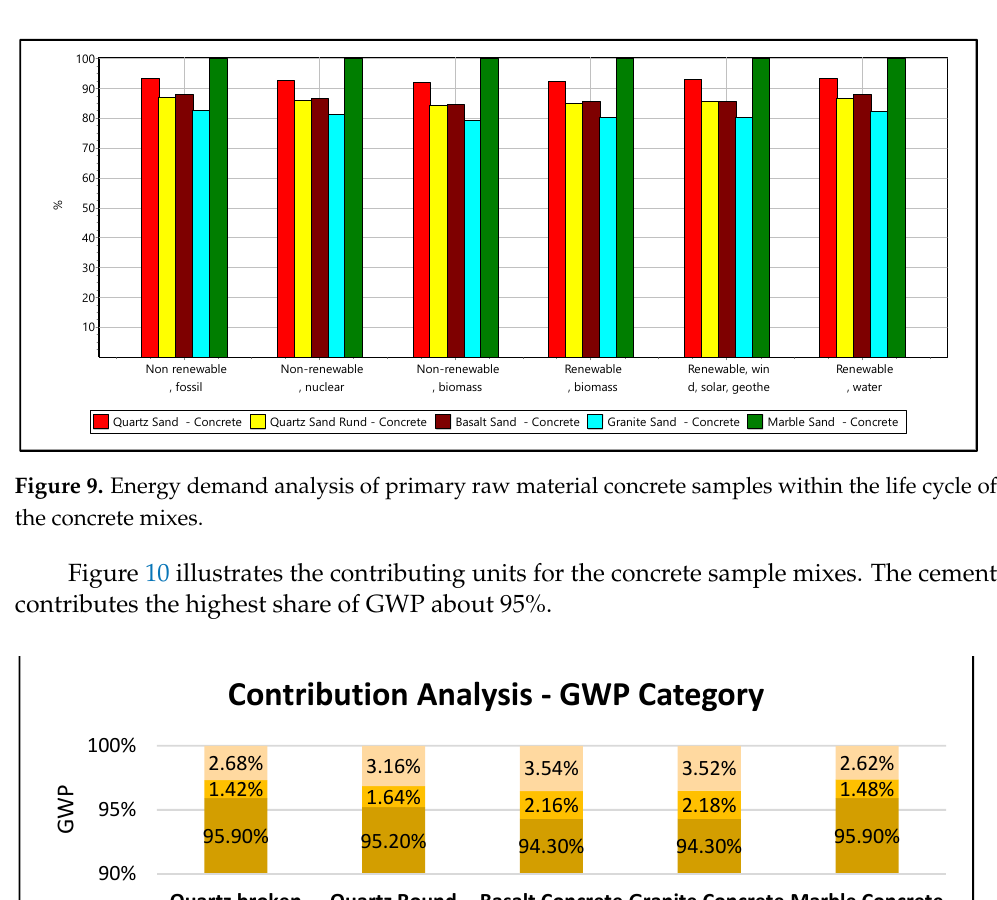
13 of 20 Figure 8. LCA comparison of primary raw material concrete samples across different impact cate- gories. Among the different aggregate usage in the concrete, the granite-based concrete has the least impact with 346 kg CO 2 eq per m 3 of concrete. The granite-based concrete has a 20% lower GWP impact than marble based concrete. The basalt concrete and crushed rounded quartz concrete has a 15% lower GWP impact than marble concrete. The cement contributes the highest share of GWP about 95%. The remaining contribution arises from aggregate about 1.4–2.18% and transportation processes contributing 2.68%–3.54%. The variation in the GWP contribution from aggregates was directly related to their mass pre- sent within the concrete mixes. Among the aggregates, the marble concrete utilizing lime- stone-based unit process shoed higher mineral resource scarcity. This could be based on the characterization values associated with limestone and the absence of such factors for other raw materials quartz, basalt, and granite. In general, the granite aggregate concrete had a lower mineral resource scarcity footprint of 3.73 kg Cu eq. The land use impact footprint remains low for quartz-based aggregates concrete, which was about 50–55% lower than other aggregate concrete. The water consumption impact remains marginally nearby for all the concrete samples ranging 3.12–3.64 m 3 , with granite aggregate concrete